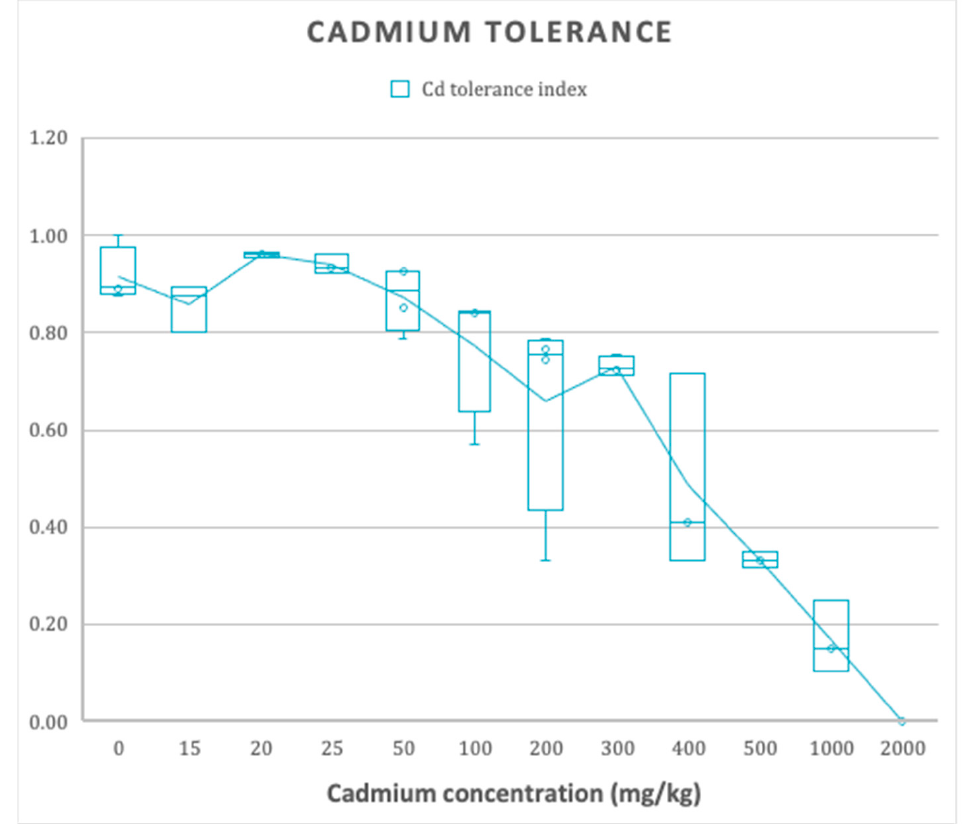
Figure 1. The effect of different concentrations of Cadmium on mycelial radial growth (Cd tolerance index of 3 replicates ± SE).